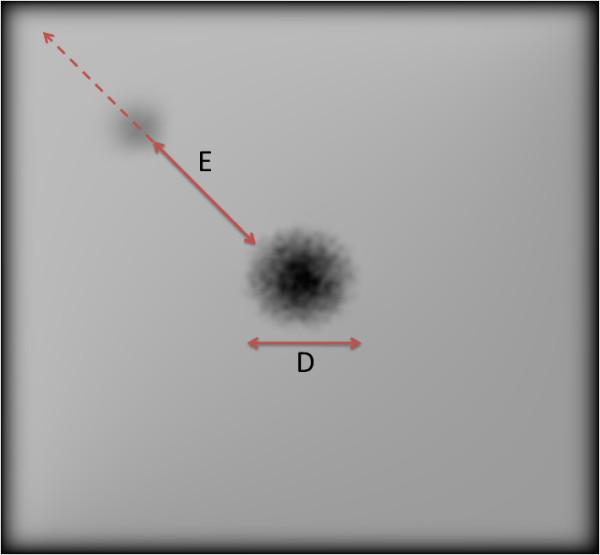
Sample of the simulated image using the Pelli Robson's contrast sensitivity test. The size of scotoma here is equivalent to the same size of macula. The contrast of object is 1.8 with eccentricity of 12.74 mm from the macula's centre. The arrows show the direction of eccentricity (E) from the macula's centre and the diameter (D) of the scotoma (which equals to the macula's diameter here).